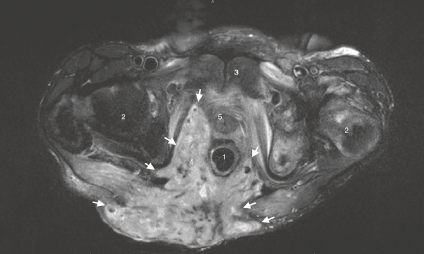
Figure 2: MRI of the pelvis shows extensive infiltration of the mass (indicated by solid arrow) into pelvic structures. (1) Rectum, (2) femoral head, (3) symphysis pubis, (4) ischiorectal fossa, and (5)